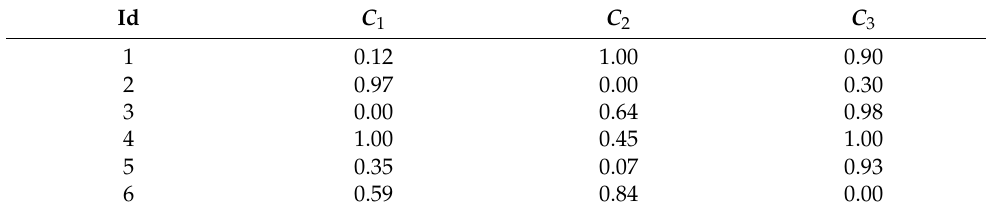
Table 4. Example students.